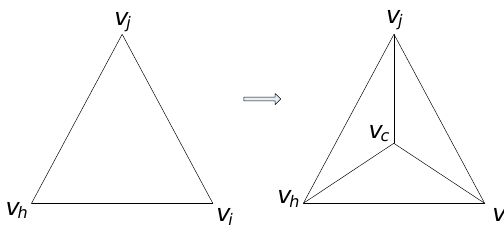
, v , v ) into three new triangles, ( v i j h , at the centroid of triangle ( v c